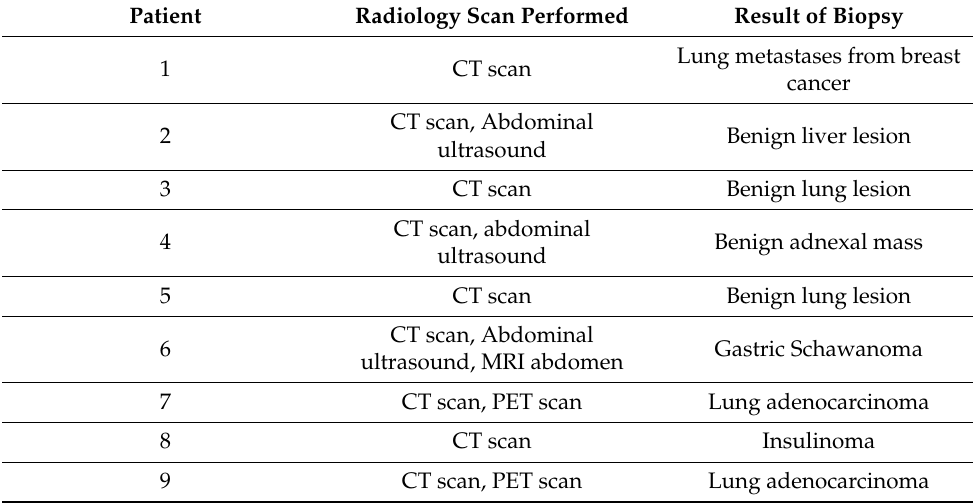
Table 3. The radiological investigations in the nine patients who underwent interventional biopsy and the results of the